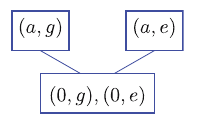
Figure 6: The eggbox of N 2 × C 1,2